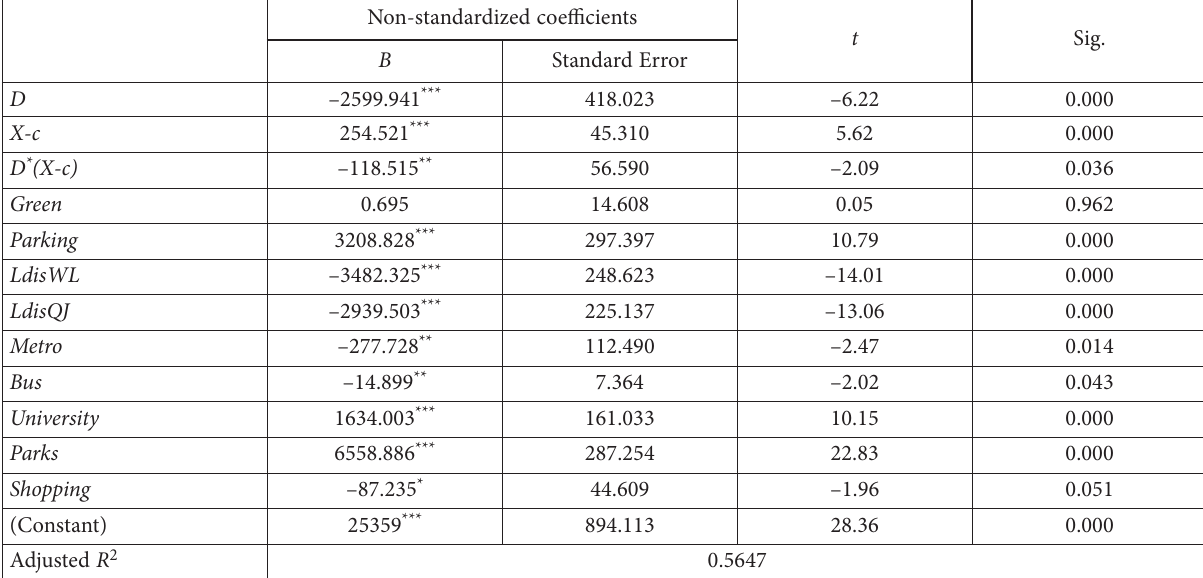
Table 2. Impact of the 2008 financial crisis using parametric